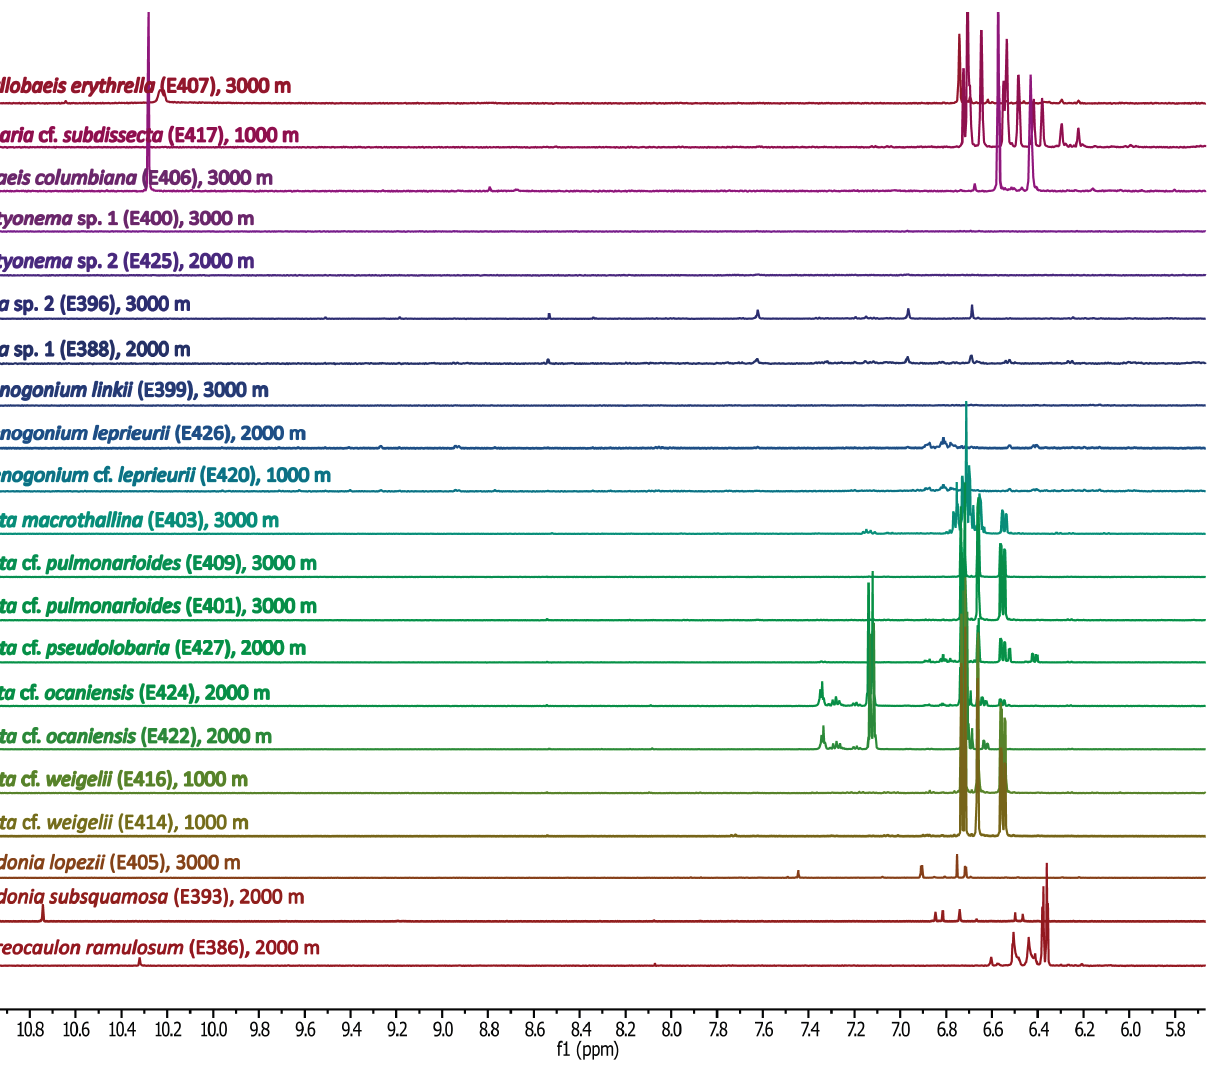
Figure 3. 1 H-NMR spectra of methanolic lichen extracts between 5.8 and 11.0